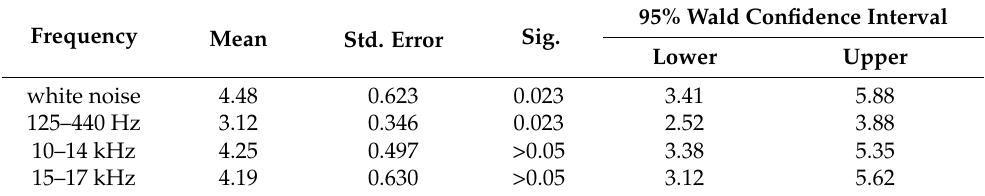
Table 7. Estimates of duration (in seconds) by frequency band.